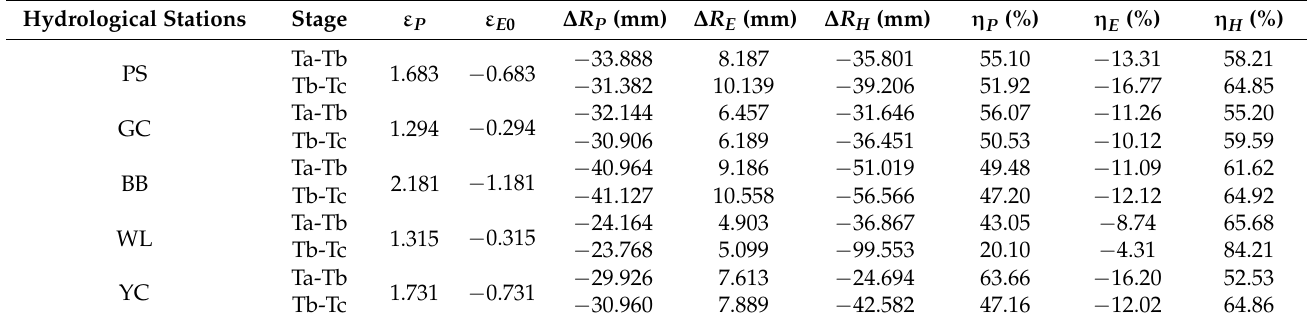
Table 5. Contribution rate of each influencing factor to